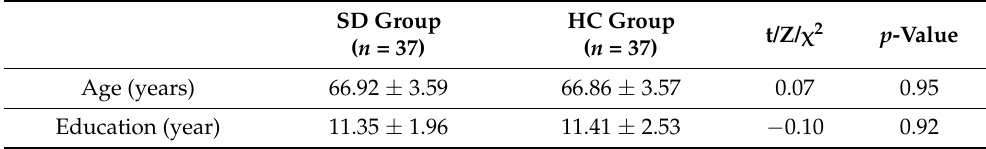
Table 2. The demographics of the SD group and HC